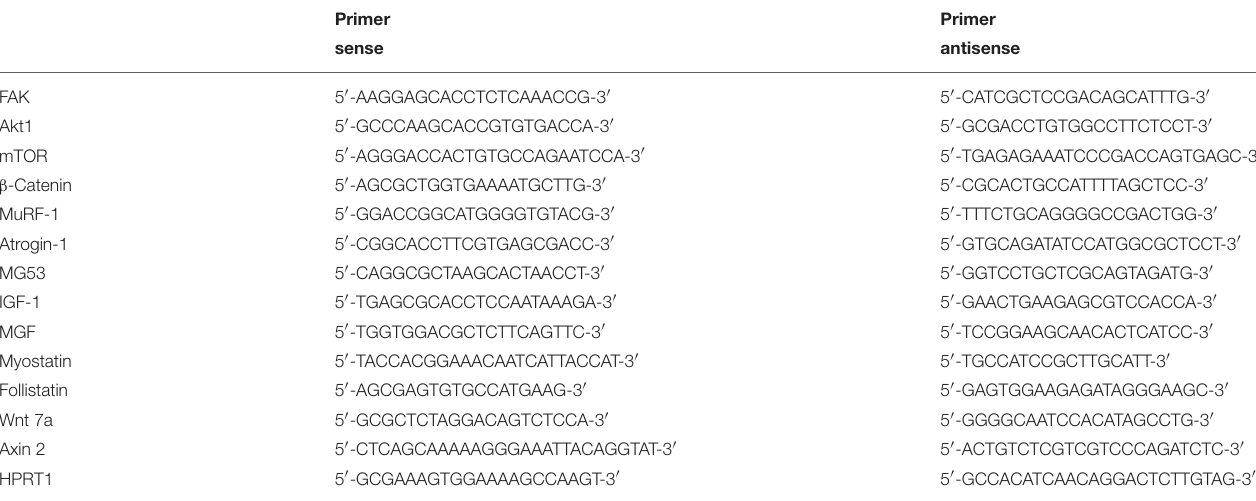
TABLE 1 | Primer sequences used for the Real-time PCR